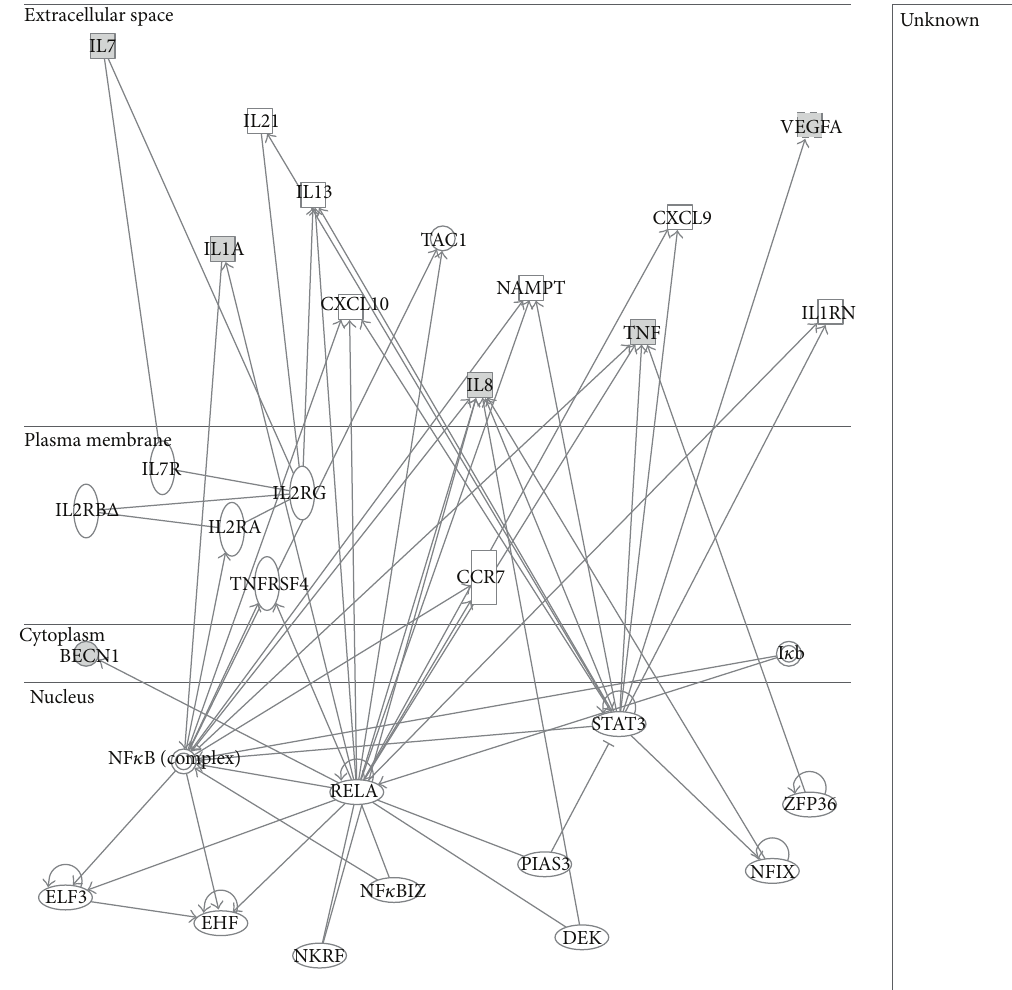
Figure 5: Significant molecules in interactomic analysis by Ingenuity Pathway Analysis (IPA). The interactome shows the close functional association between five significant cytokines and BECN1 (evidenced with cyan symbols) and other functionally relevant molecules (evidenced with white